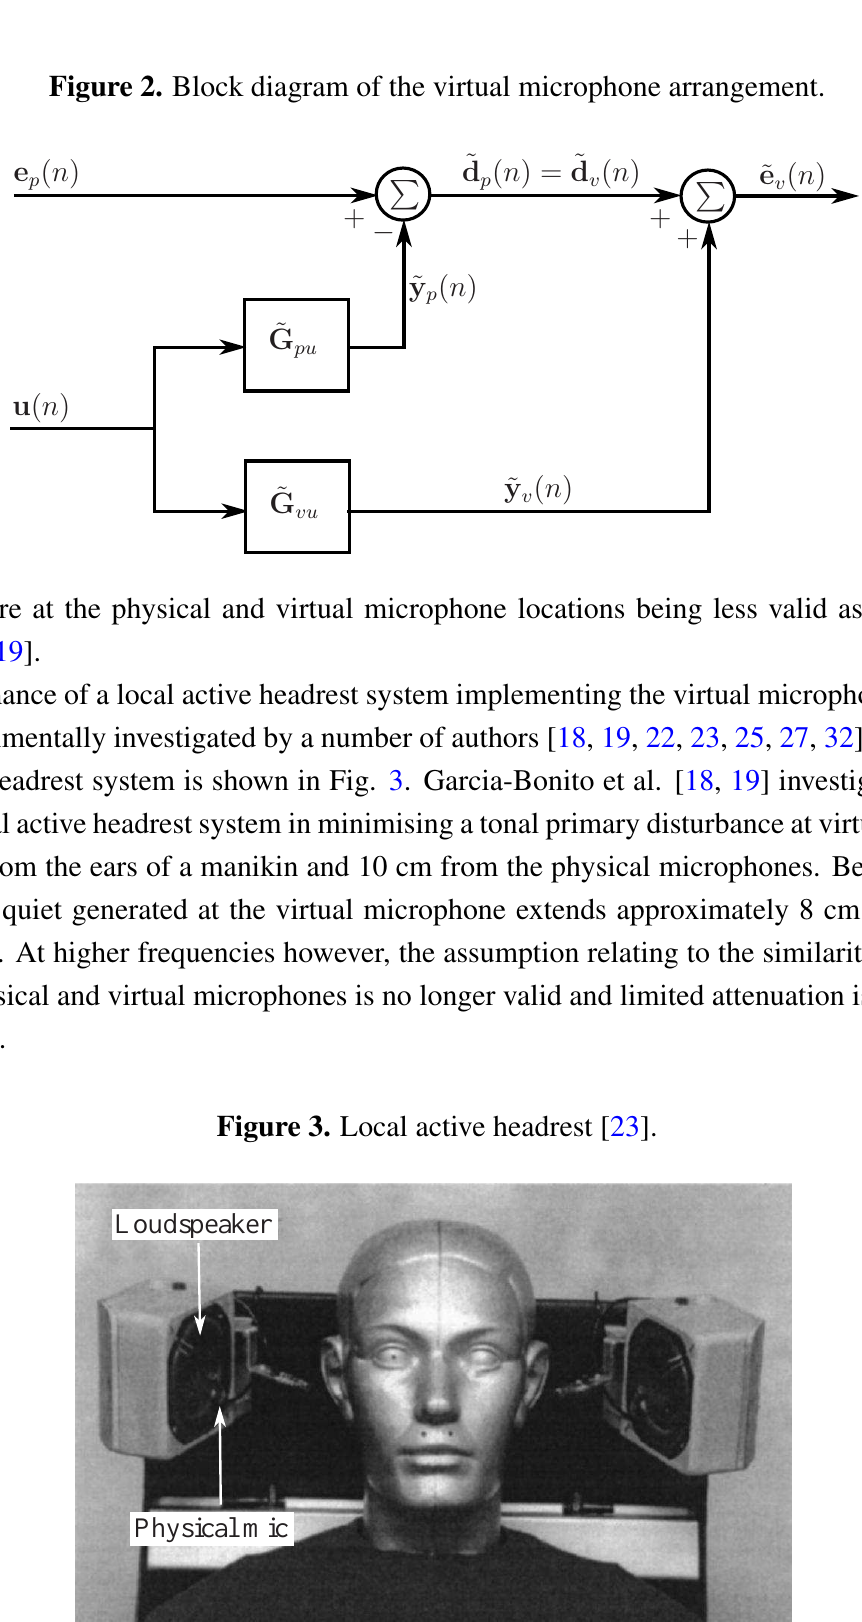
Figure 3 . Local active headrest [23].